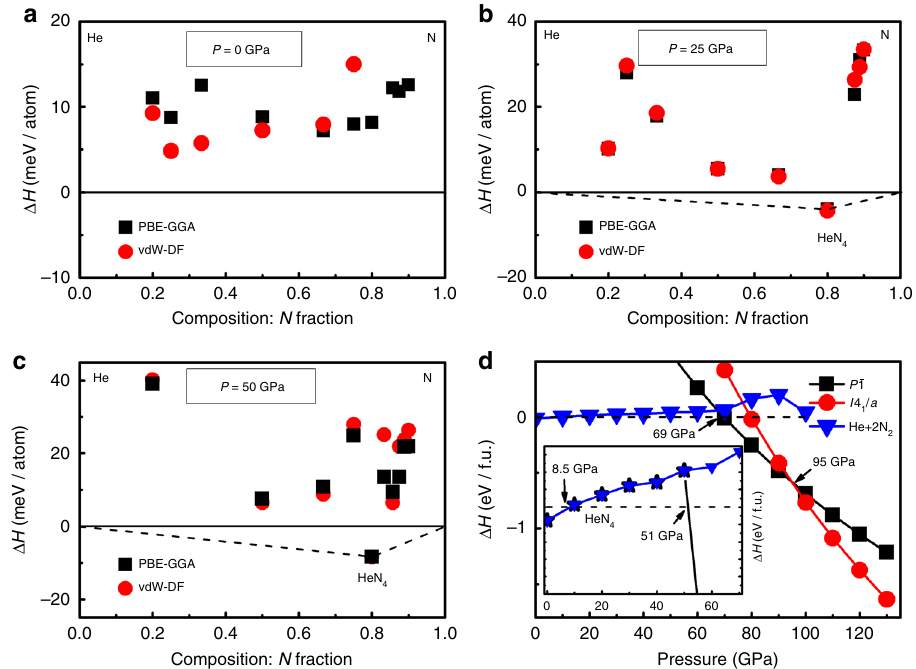
Fig. 1 Thermodynamic stability of the predicted structures. Results from structure searching at 0 ( a ), 25 ( b ) and 50 ( c ) GPa. Convex hulls are shown as continuous lines, with (red) and without (black) the inclusion of vdW corrections. hcp- He 50 at 0, 25 and 50 GPa, α -N 2 51 at 0 GPa and ε -N 2 52,53 at 25 and 50 GPa were adopted in the calculation. d Calculated enthalpy curves of the I 4 1 / a and P 1 structures with respect to the C 2/ c structure for HeN 4 as a function of pressure. The decomposition enthalpy (blue triangles) into hcp -He plus molecular N 2 ( α -N 2 at 0 GPa and ε -N 2 above 0 GPa) was also plotted. Inset in d is an enlarged view of the decomposition enthalpy in pressure range 0 – 70 GPa. Black stars in inset represents the decomposition enthalpy curves of HeN 4 into (He + 4 N) as a function of pressure, where cg -N was considered at pressures above 54